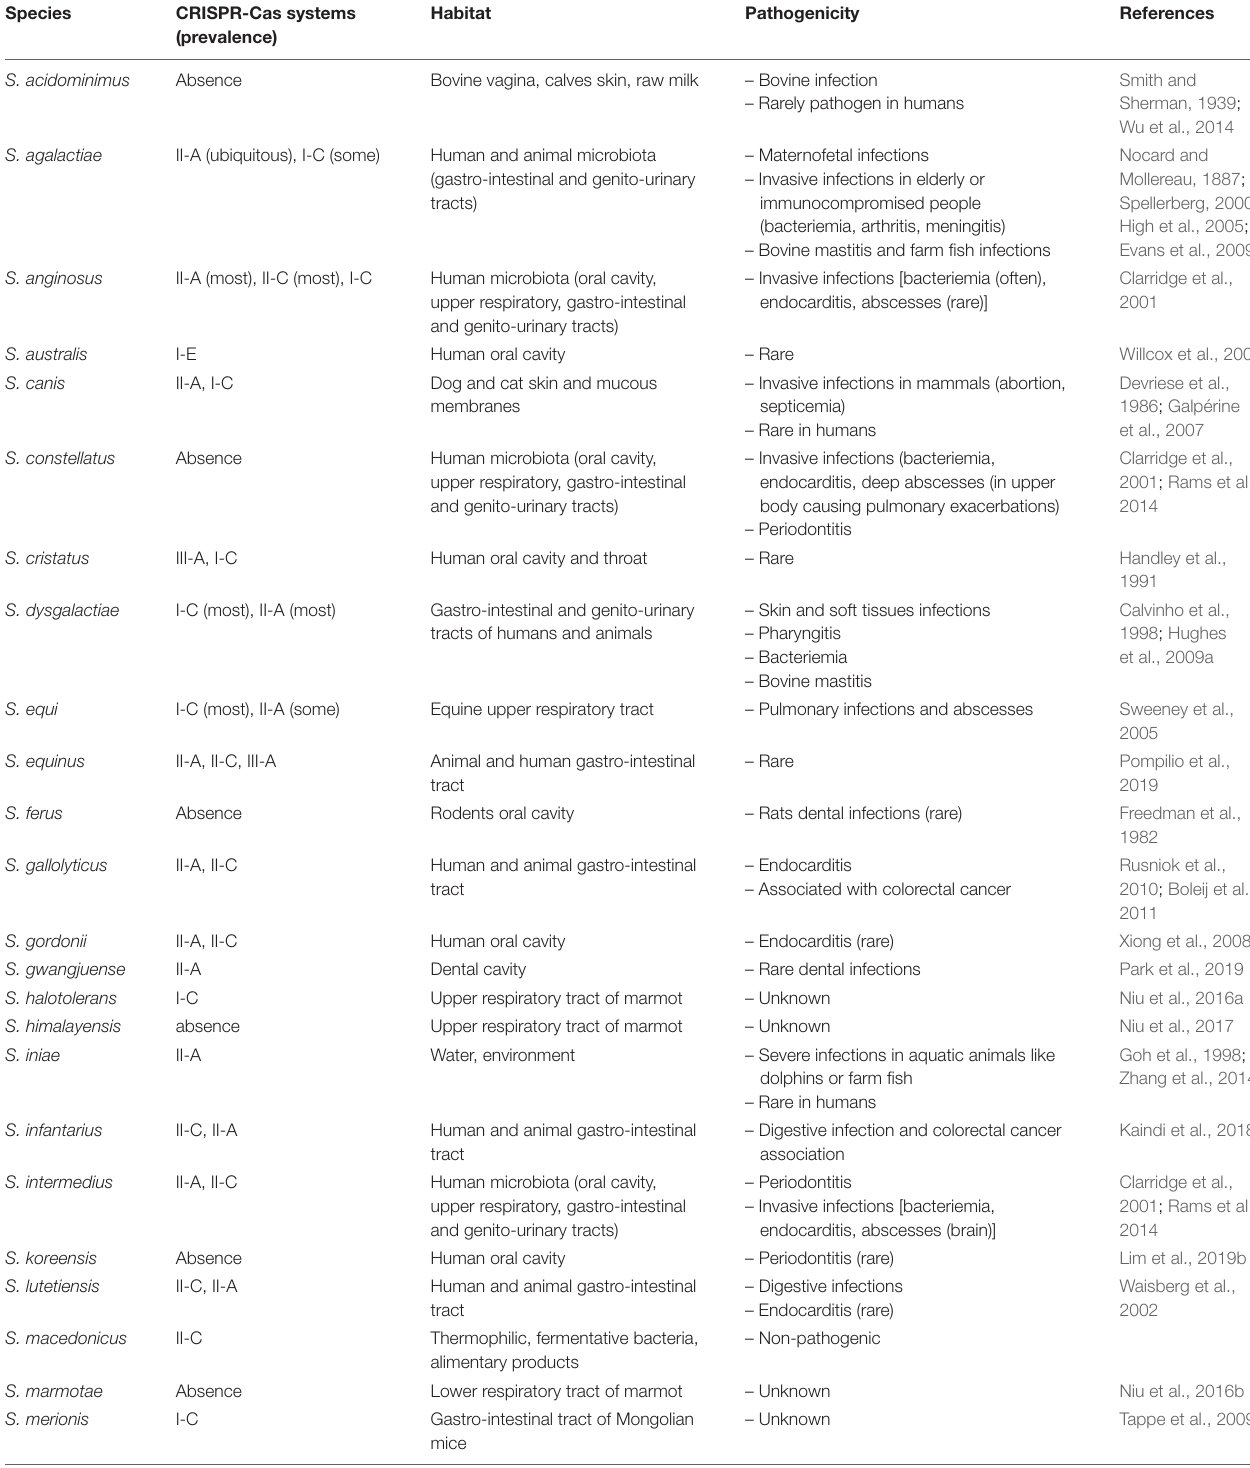
TABLE 1 | Distribution of CRISPR-Cas systems in streptococci, with habitat and pathogenicity of all these species, based on CRISPRCasfinder analysis, available at https://crisprcas.i2bc.paris-saclay.fr/MainDb/StrainList (Grissa et al., 2007a).